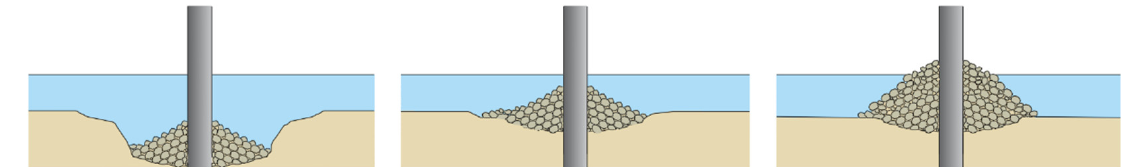
Figure 2. Pier scour countermeasure retrofitting cases distinctive by the position of the top of the riprap sloping structure relative to the riverbed level: top of the riprap below the general bed level ( left ); top of the riprap above the general bed level ( middle ); and top of the riprap above the mean water level ( right ).